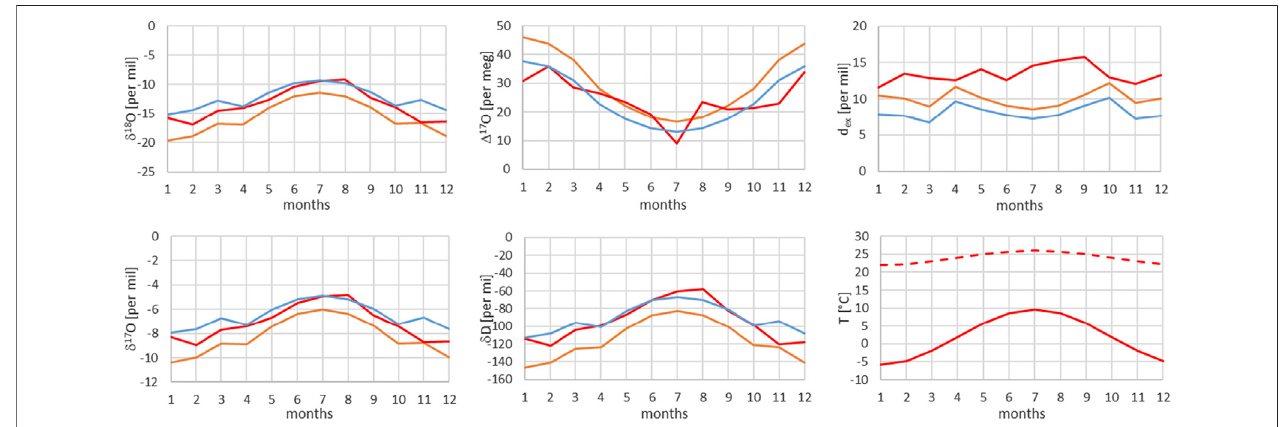
FIGURE 12 | Comparison of monthly mean measured (red) and modeled (for the isobaric case (orange) and for the dry adiabatic case (blue)) isotope ratios for Grimsel. The dashed red line corresponds to the assumed source temperature.